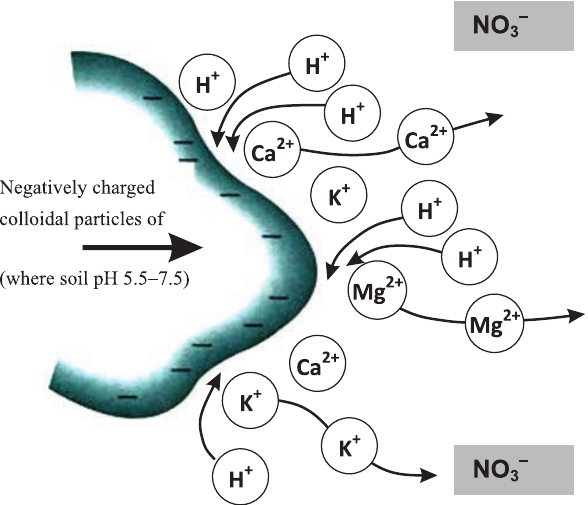
Fig. 3. Effect of nitrates on the absorptive barrier of heavy